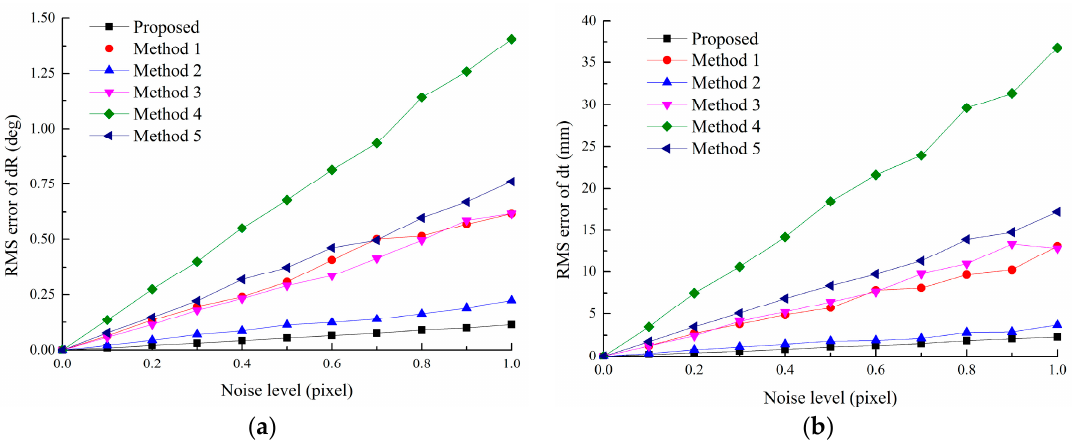
Figure 8. Calibration error vs. the noise level: ( a ) RMS error of rotation vs. the image noise; ( b ) RMS error of translation vs. the image noise.